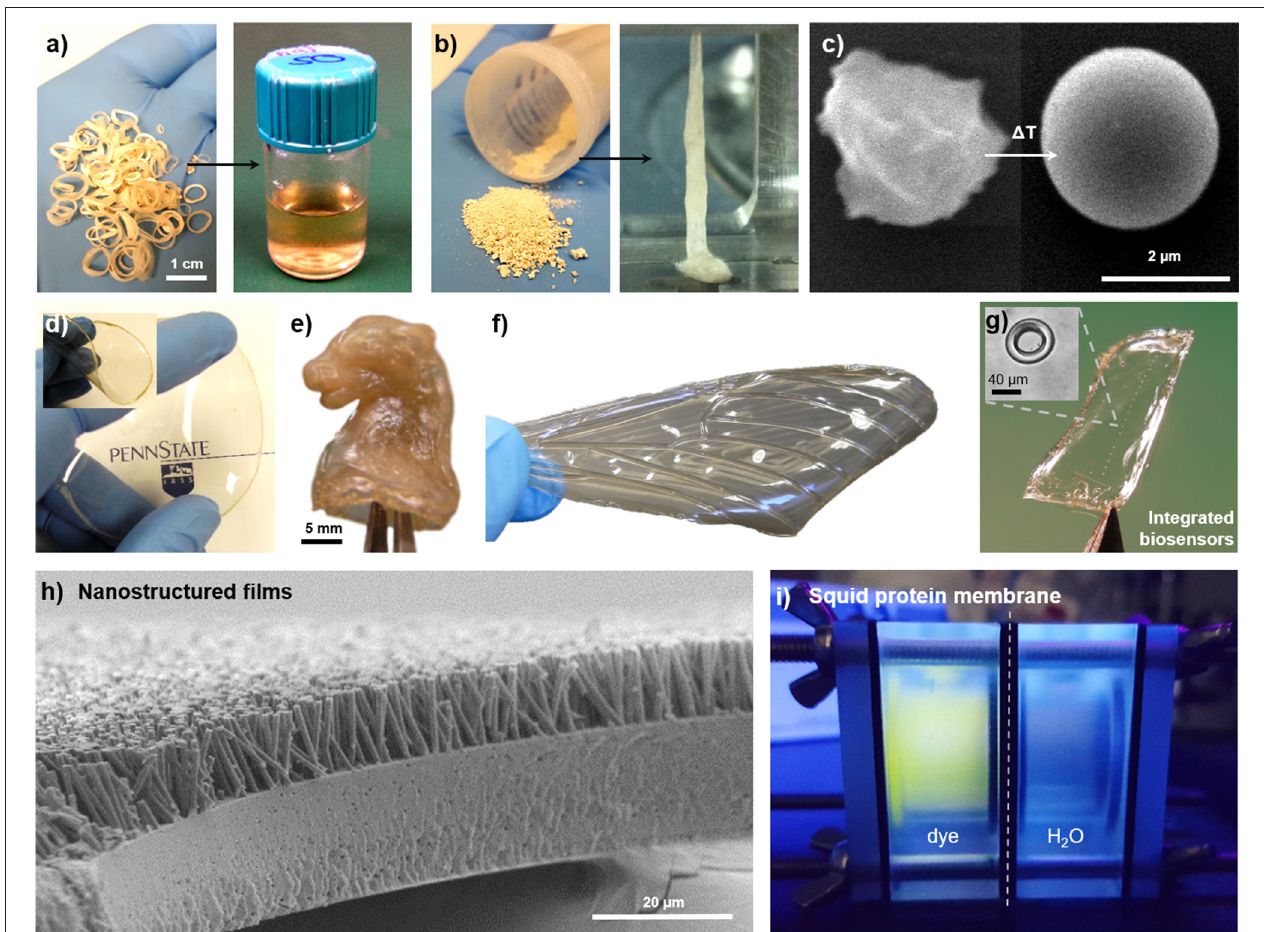
FIGURE 4 | Multifunctional films fabricated from squid-derived proteins. SRT proteins are processed via (a) solution-based or (b) thermal-based methods into a variety of materials. Reproduced with permission (Pena-Francesch et al., 2014b). Copyright 2014 Wiley. (c) Colloids. Reproduced with permission (Pena-Francesch et al., 2014b). Copyright 2014 Wiley. (d) Free-standing transparent flexible films. Reproduced with permission (Yilmaz et al., 2017). Copyright 2017 American Chemical Society. (e) Complex 3D geometries. Reproduced with permission (Pena-Francesch et al., 2018b). Copyright 2017 American Chemical